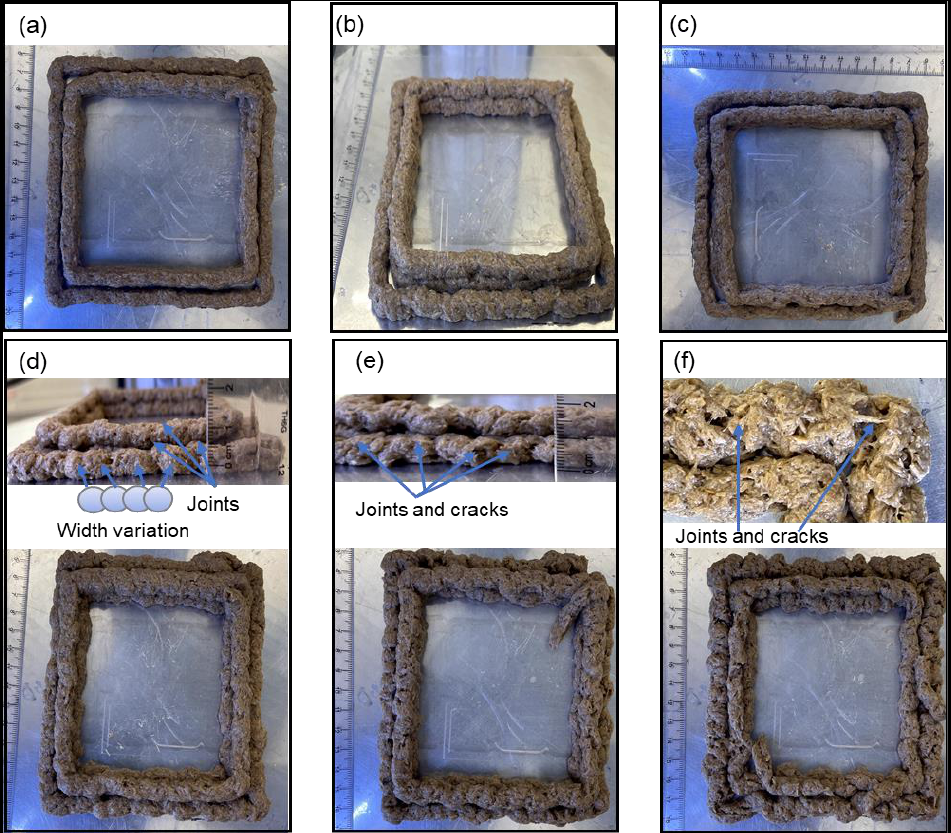
Figure 16. Samples printed at different levels of waiting time: ( a ) 0.5 h; ( b ) 1.5 h; ( c ) 2.5 h; ( d ) 4.5 h; ( e ) 6.5 h; ( f ) 8.5 h.